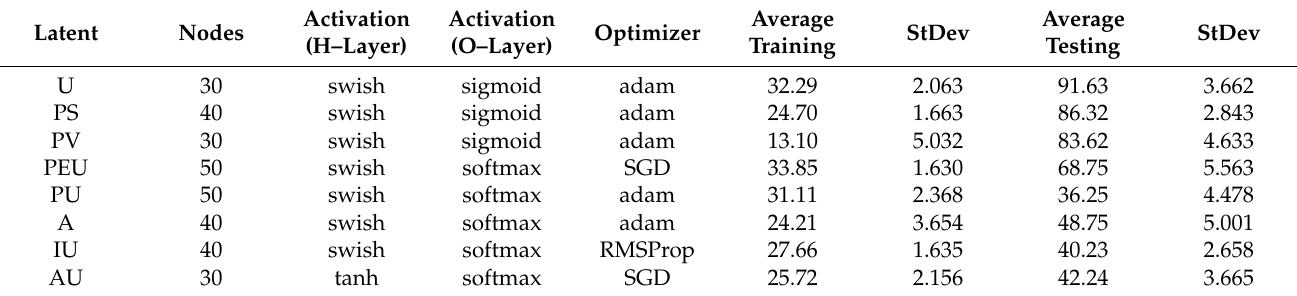
Table 4. Summary of Initial Deep Learning Neural